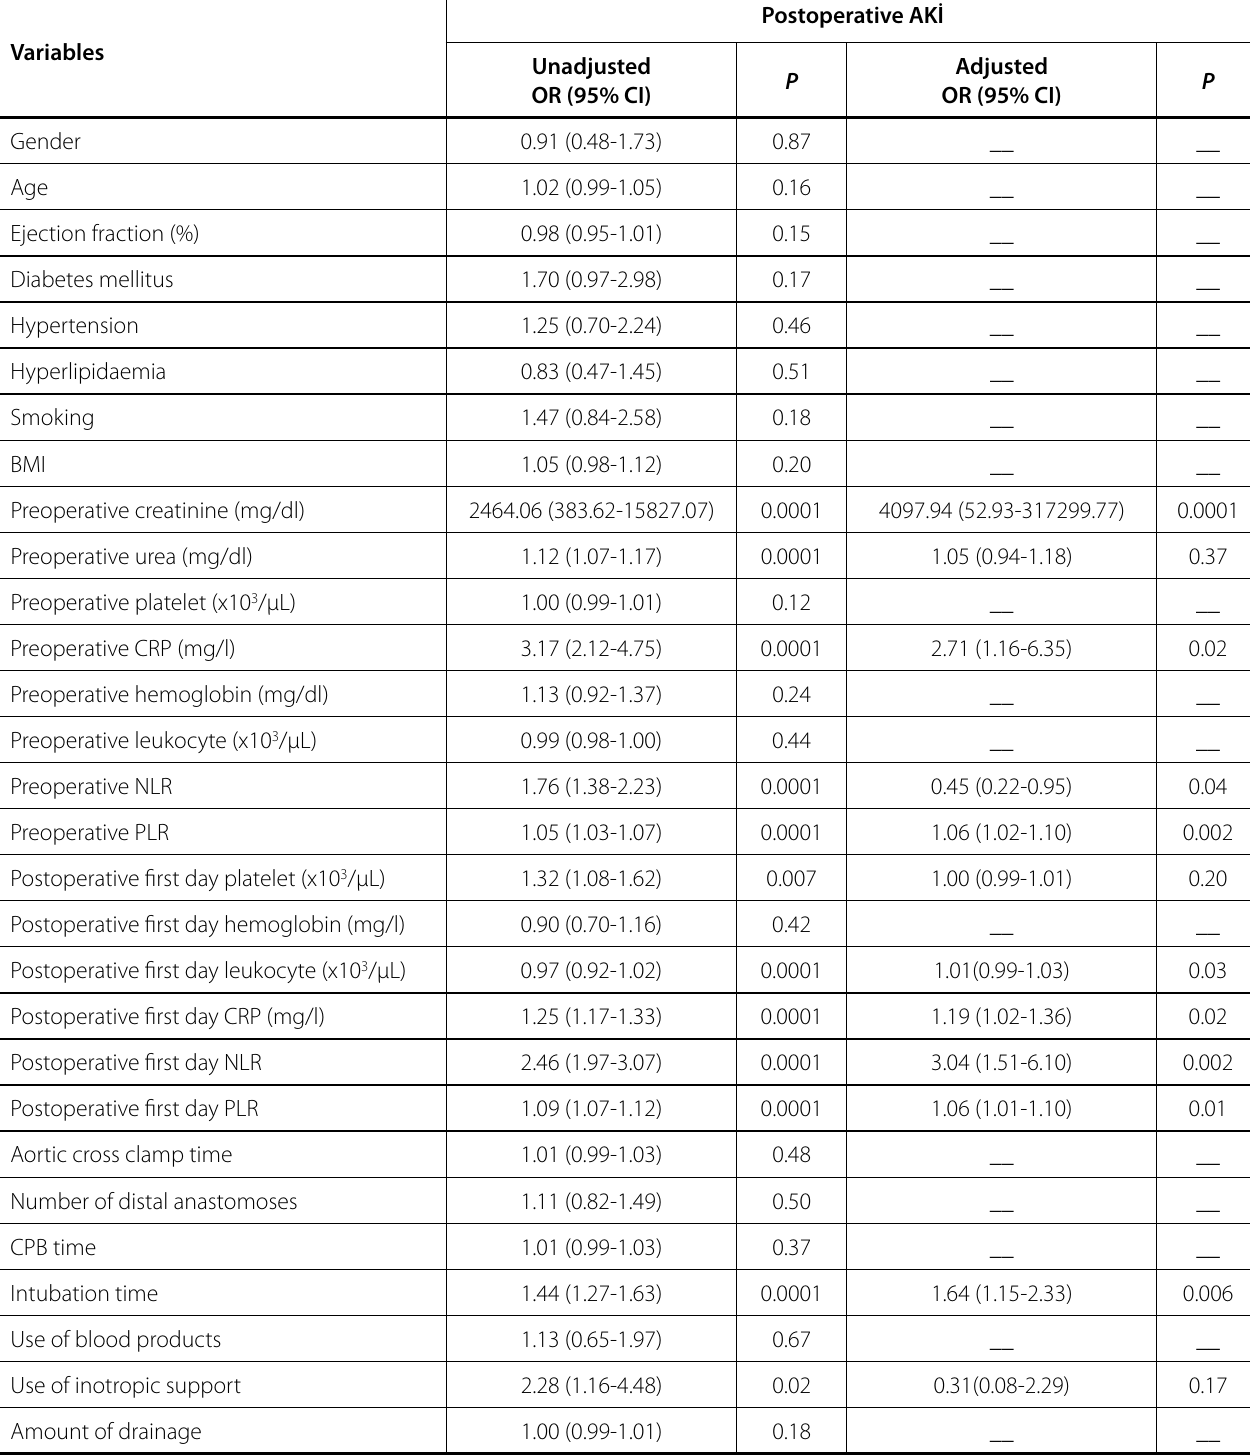
Table 5. Univariate and multivariate regression analyses of preoperative, operative and early postoperative risk factors for postoperative